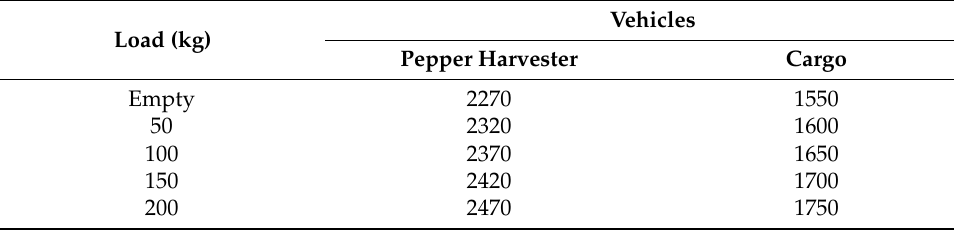
Table 2. Weight of each vehicle with the loading